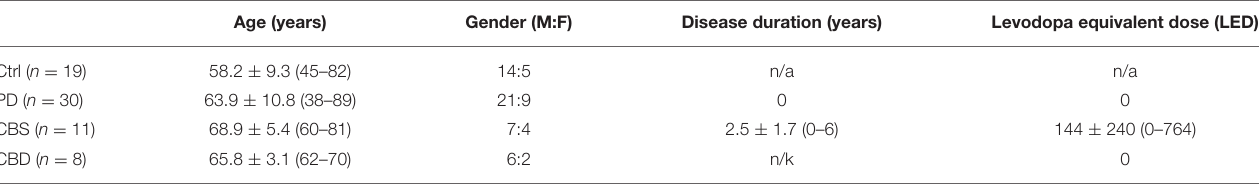
TABLE 1 | Demographics of examined controls (Ctrl) and patients with Parkinson’s Disease (PD), Corticobasal syndrome (CBS), and Corticobasal degeneration (CBD). Age (years) Gender (M:F) Disease duration (years) Levodopa equivalent dose